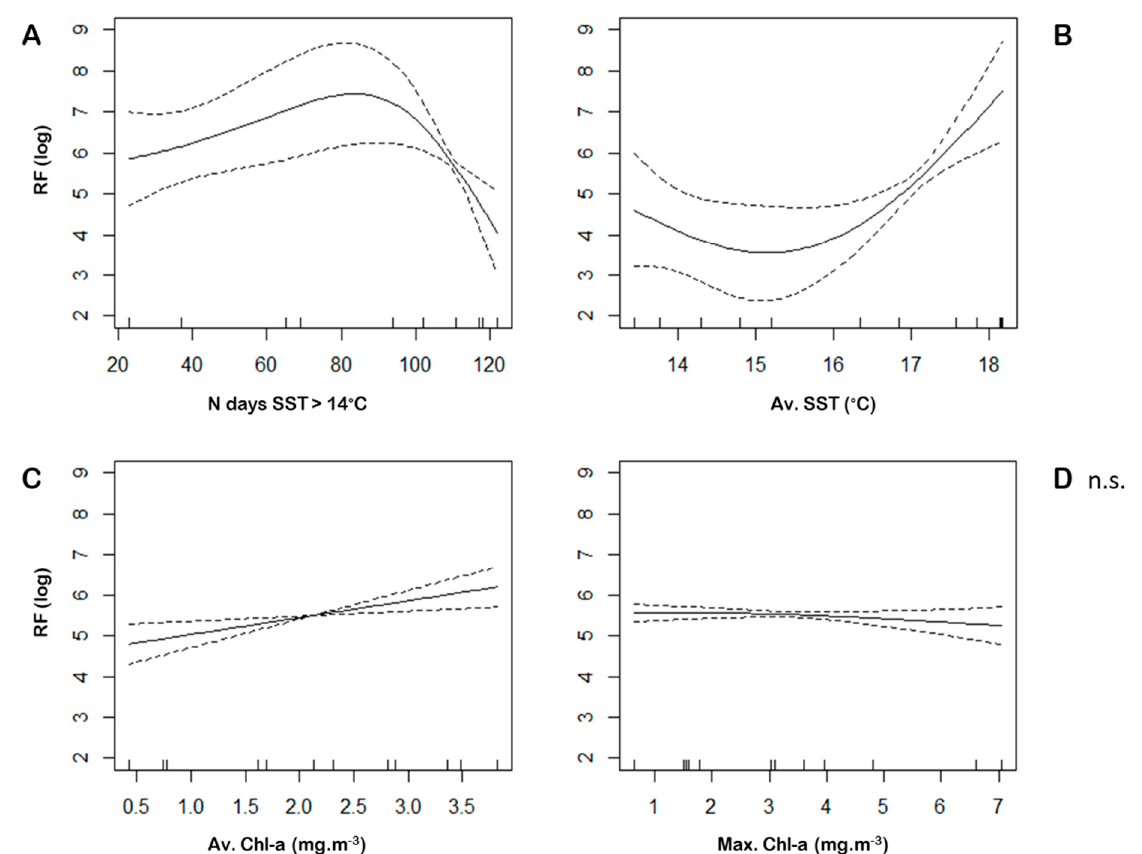
Figure 5. Results of the General Additive Model showing the best subset of environmental variables explaining relative fecundity (RF, log) along the Portuguese coastline, during 2014 and 2017 (grouped years). ( A ) Number of days with Sea Surface Temperature higher than 14 ◦ C at last 4 months (N Days SST > 14 ◦ C). ( B ) Average of Sea Surface Temperature (Av. SST, ◦ C) and ( C ) Chlorophyll-a (Av. Chl-a, mg/m 3 ) at last month before samples. ( D ) Chl-a concentration during 10 days around the peak of the spring transition (max. Chl-a). Dashed lines show 95% Confidence Interval and tick marks along the x -axis represent where the RF values (points) occurred.